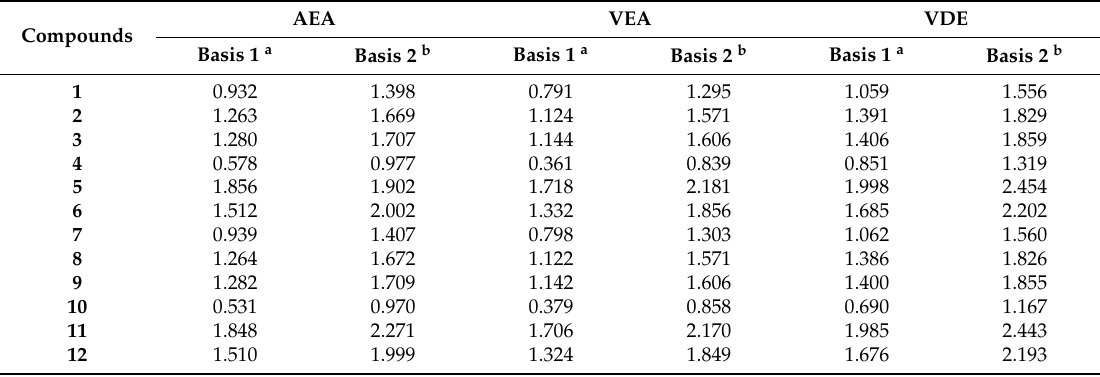
Table 3. Calculated Adiabatic Electron affinities (AEAs), vertical electron affinities (VEAs), and vertical detachment energies (VDEs) for molecules 1 – 12 in vacuum with the B3LYP/6-31G(d) a , and B3LYP/6-311+G(2df,p)// B3LYP/6-31G(d) b , basis sets c .